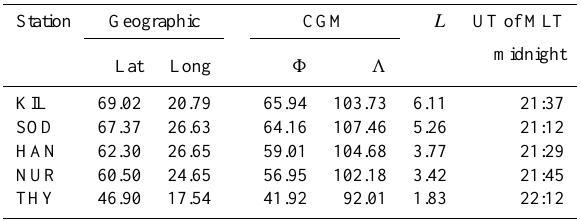
Table 1. Coordinates of MM100 stations GOES